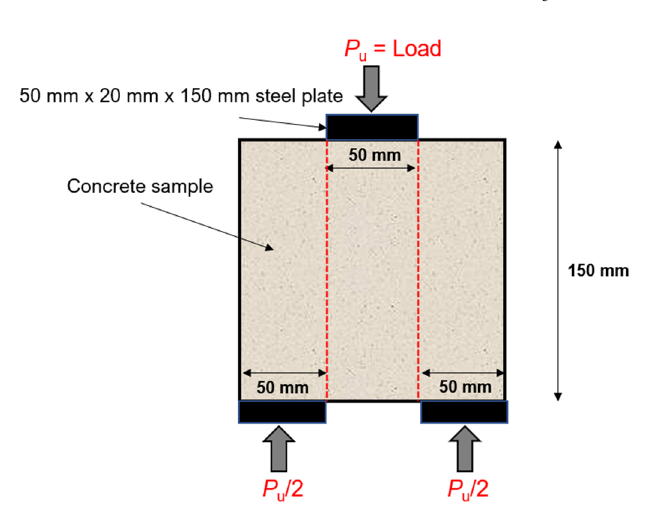
Figure 5. Schematic representation of bi-surface shear test.